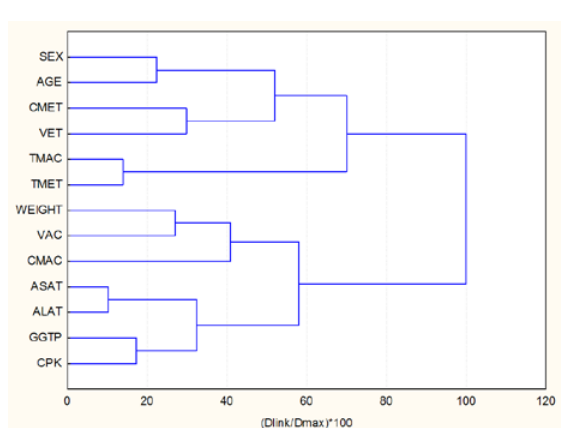
Figure 3. Hierarchical dendrogram for grouping of 13